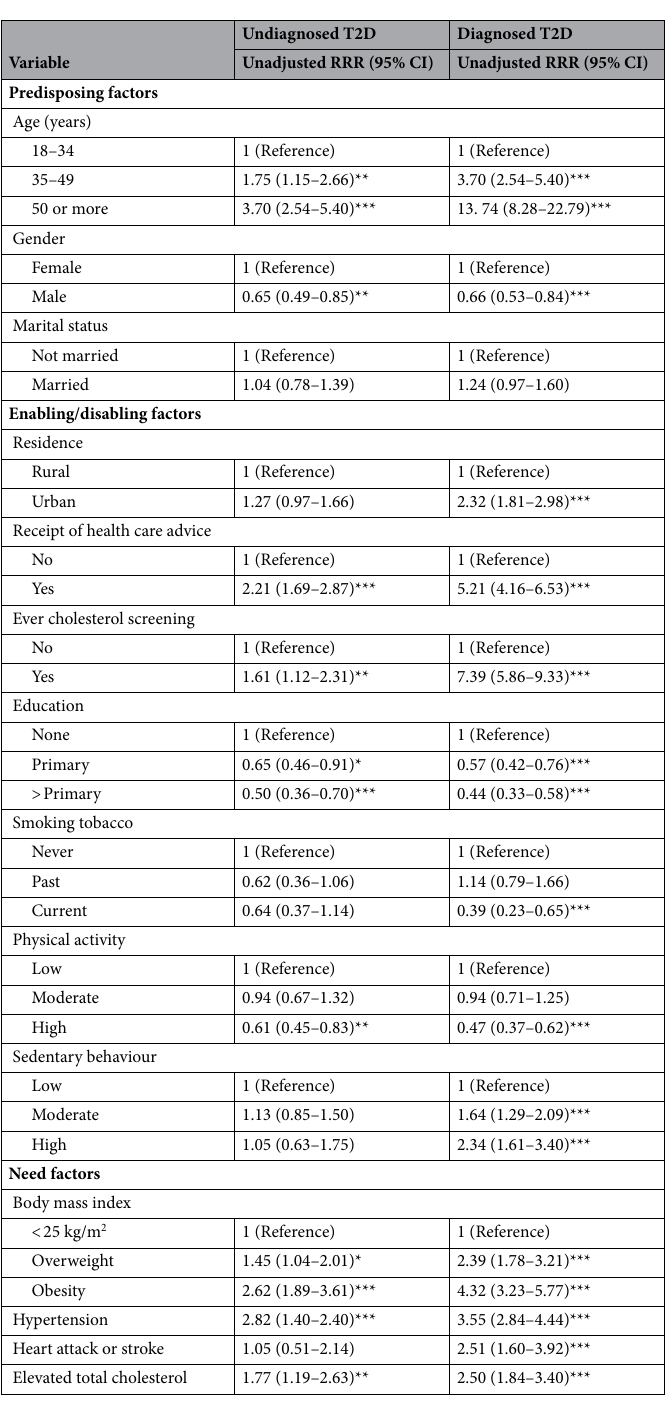
Table 2. Relative risk ratios for factors associated with undiagnosed and diagnosed type 2 diabetes (T2D) in Moroccan adults, 2017. RRR Relative, CI Confidence intervals. * p < 0.05; ** p < 0.01; *** p <